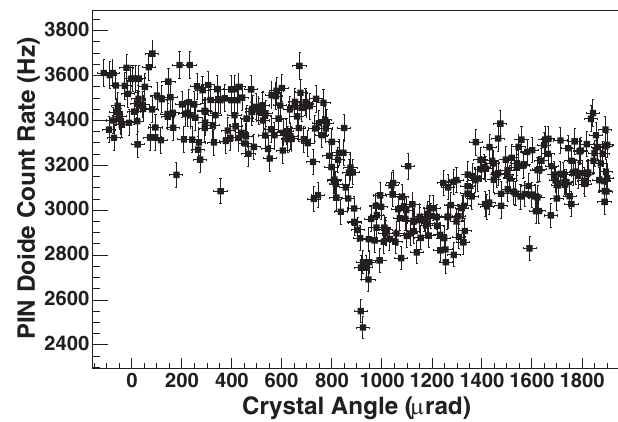
FIG. 9. (Color) Data from Fig. 8 after averaging. The red line corresponds to the fit to Eq. (14).